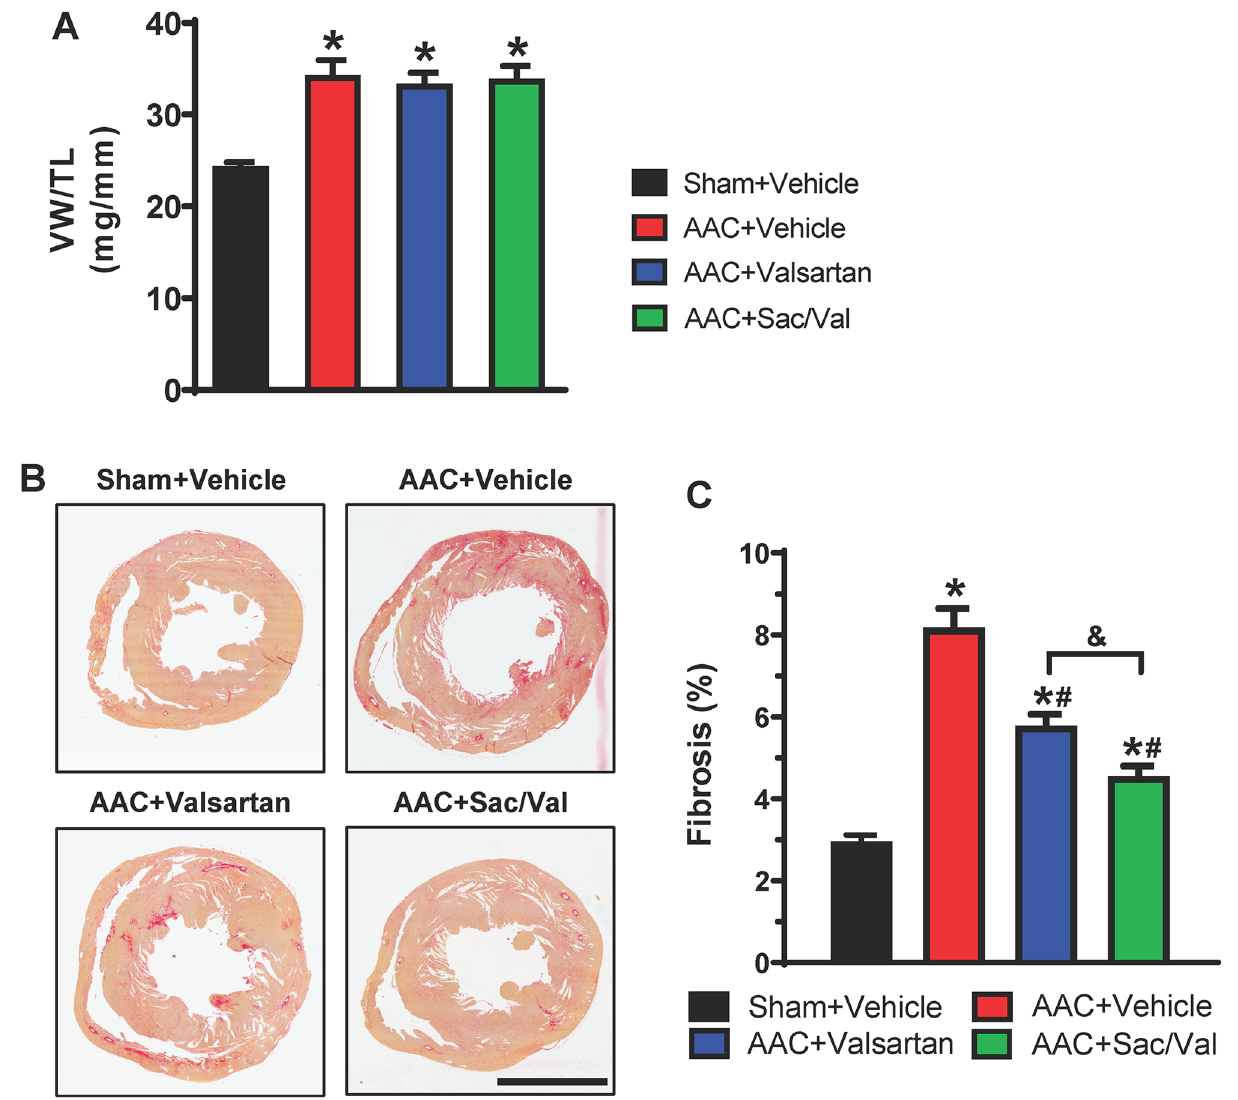
Figure 2. Sacubitril/valsartan is superior to valsartan in reducing ventricular fibrosis in response to persistent LV pressure overload. ( A ) Ventricular weight to tibia length ratios (VW/TL) after 10-week treatment. N = 8–11 rats per group. Mean ± SEM. * P < 0.05 versus Sham + Vehicle. ( B,C ) Representative images ( B ) and quantitation ( C ) of Picrosirius Red staining on ventricular cross-sections from indicated rats described in Fig. 1A. Scale